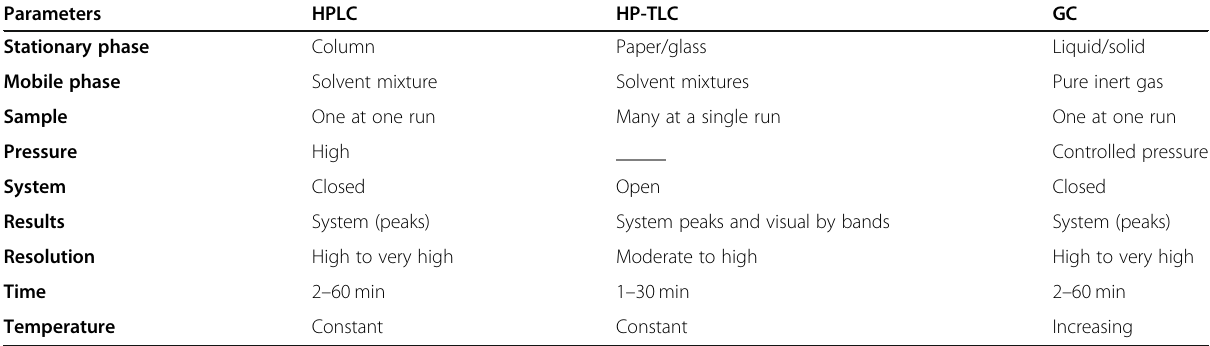
Table 2 Comparison of chromatographic techniques [60 –